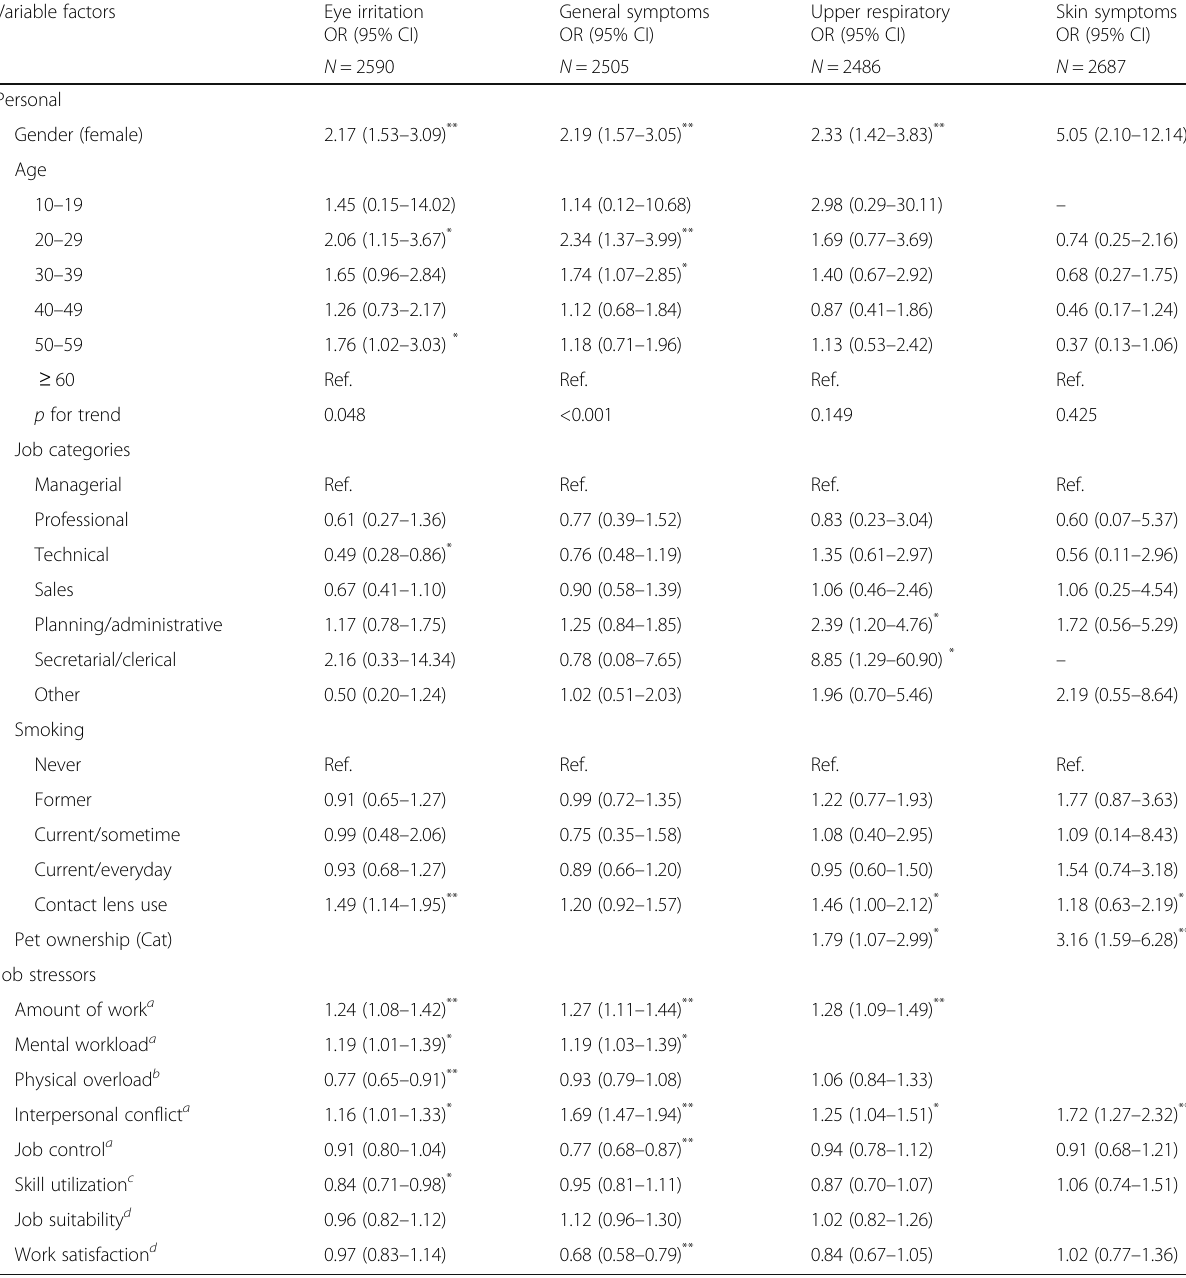
Table 3 The association of weekly building-related symptoms with personal factors and job stressors (Model 1) Variable